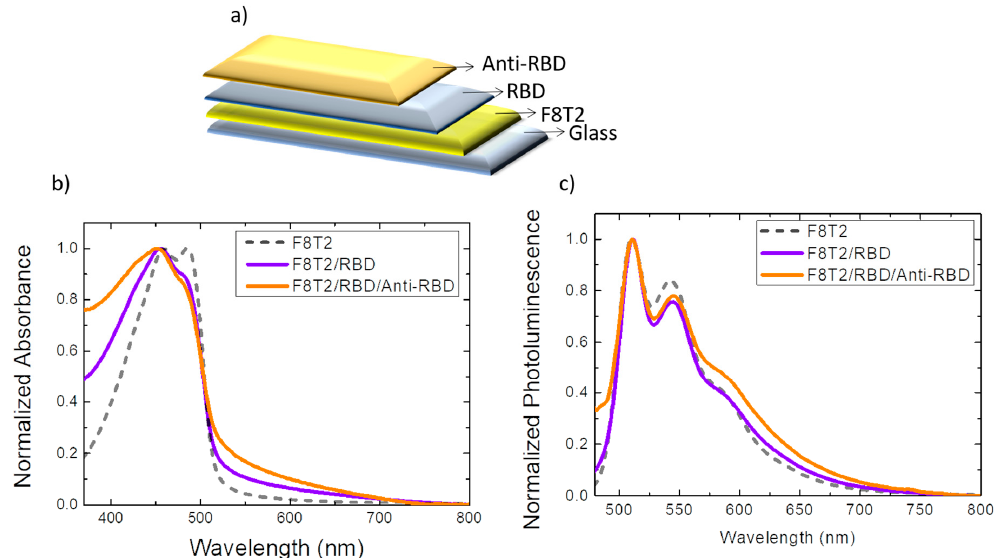
Figure 1. ( a ) Assembly diagram of the optical biosensor configuration GLASS/F8T2/RBD/anti-RBD. Optical properties of films for the optical biosensor construction: ( b ) normalized absorption spectrum; ( c ) normalized photoluminescence spectrum (excitation at 450 nm). Absorption and photoluminescence spectra of the F8T2 film were plotted by comparison.